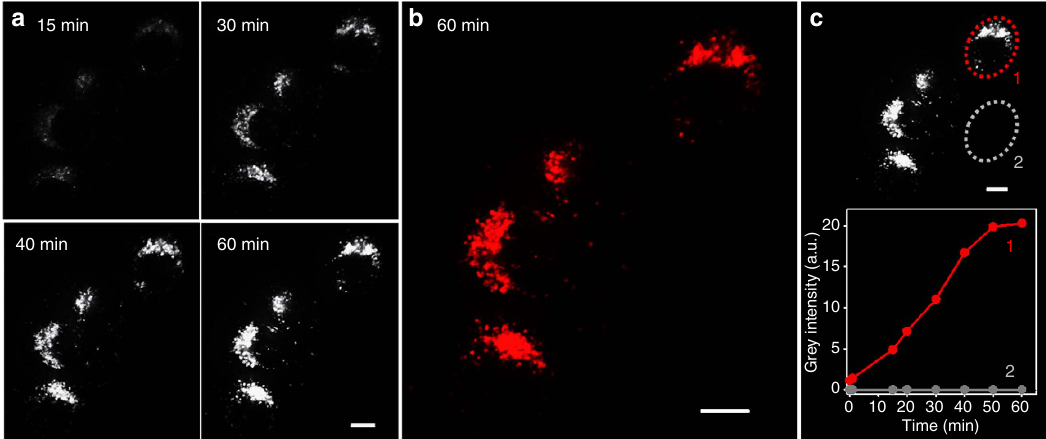
Figure 9 | Z -axis projections of widefield 4D live-cell imaging of the uptake of 2 (10 l M) from HeLa Kyoto cells. Images were acquired in 25 focal planes every 1min for 60min. ( a ) Time lapse b/w images are shown for 15, 30, 40 and 60min. ( b ) Red-coloured image at 60min. ( c ) Fluorescence intensity quantification in two identical volumes around a selected cell (1) and in the extracellular environment (2). Scale bars, 10 m